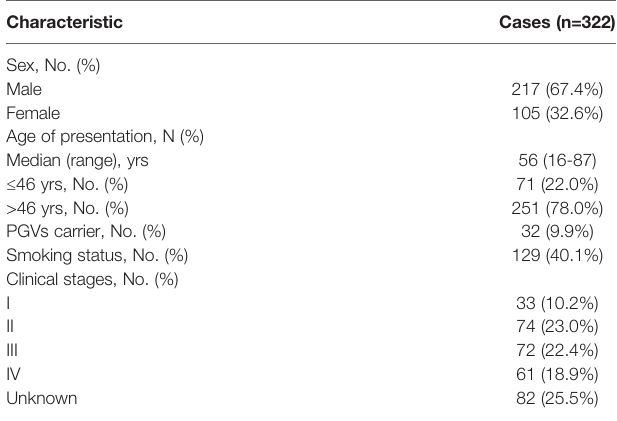
TABLE 1 | Patient demographic and clinical